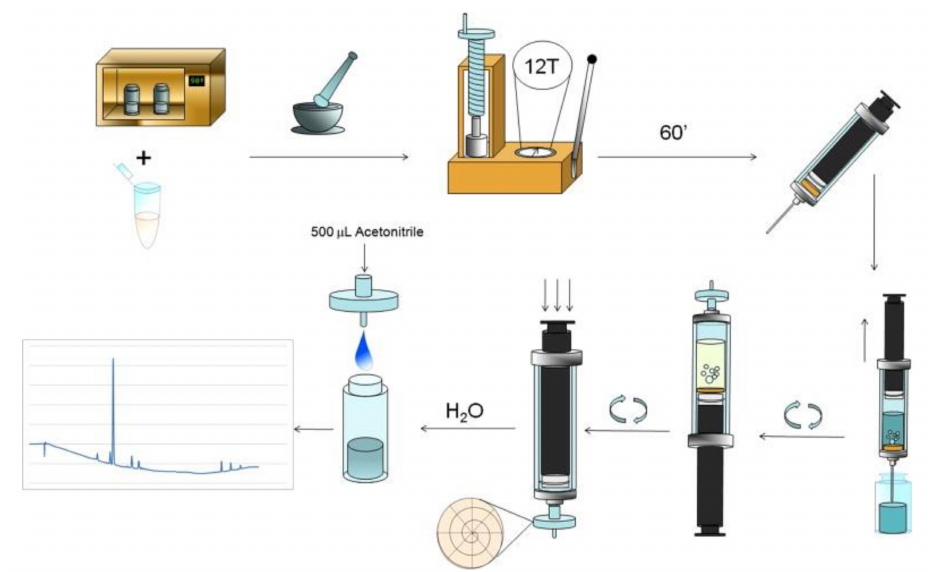
Figure 1. Description of the general analytical procedure of the e ff ervescence-assisted dispersive micro-solid phase extraction. Reproduced with permission of Elsevier from reference